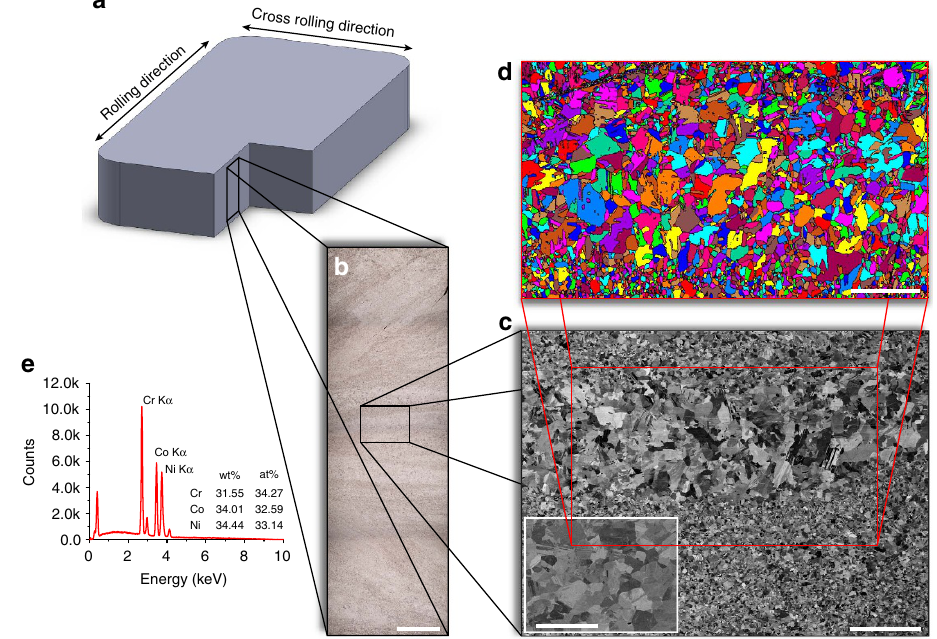
Figure 1 | Processing and microstructure of the medium-entropy alloy CrCoNi. ( a ) The material was processed by arc melting, drop casting, forging and rolling into sheets of roughly 10mm thickness from which samples for cross-sectional analysis, tensile tests and fracture toughness tests were machined. ( b ) Optical microscopy image shows the varying degree of deformation through the thickness of the sheets. ( c ) Scanning electron microscopy images reveal the non-uniform grain size of the material resulting from the deformation gradients, equiaxed grains and numerous annealing twins after recrystallization (inset). ( d ) Grain maps from electron back-scatter diffraction scans confirm the varying grain size and show the fully recrystallized microstructure. ( e ) Energy-dispersive X-ray spectroscopy verifies the equiatomic character of the alloy. The scale bars in b , c and the inset of c and d are 1mm, 200 m m, 20 m m and 150 m m,